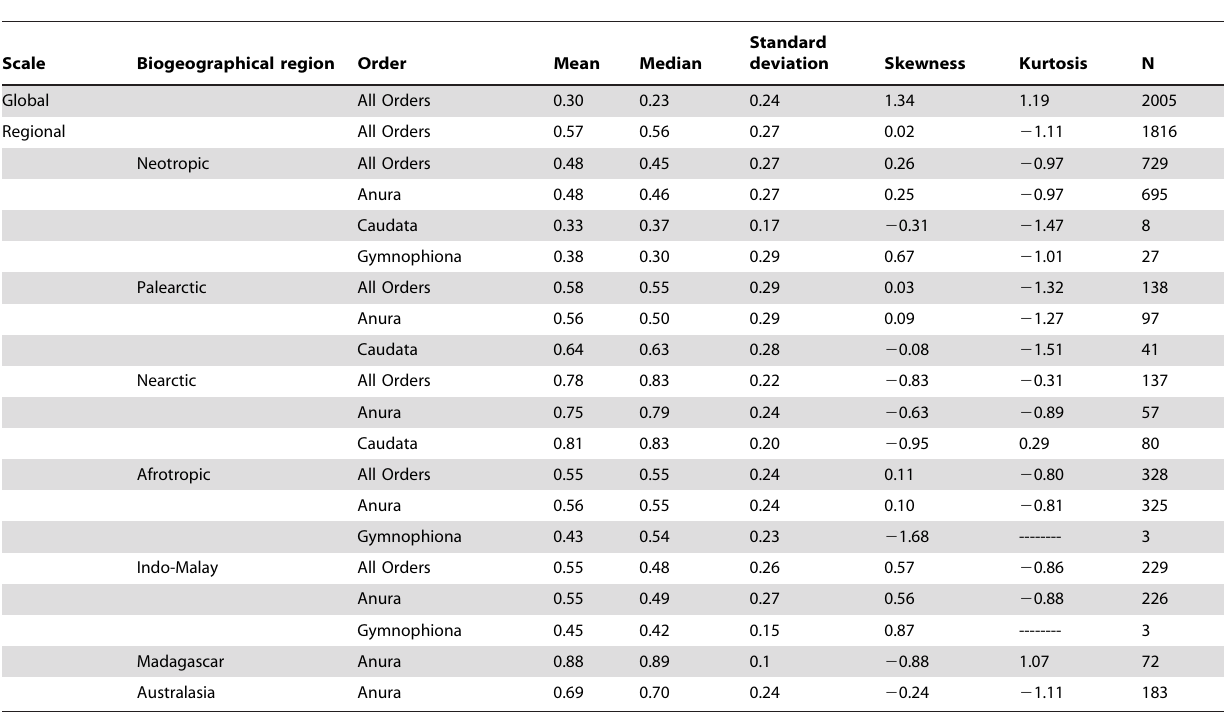
Table 2. Descriptive statistics of the level of equilibrium among